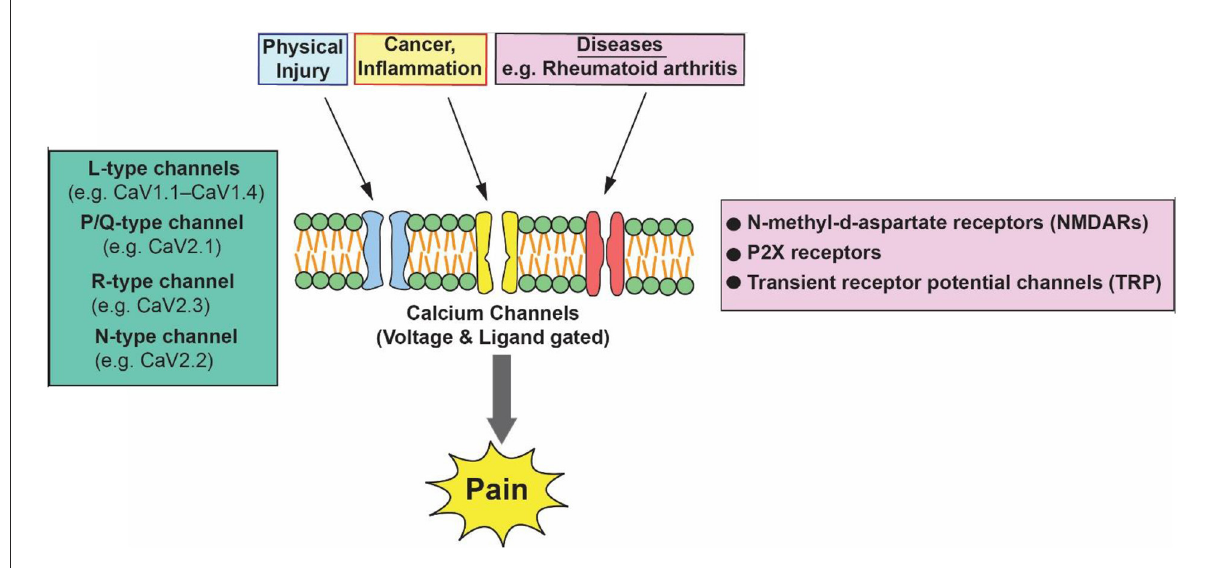
FIGURE1 Regulatory action of voltage-gated calcium channels in pain